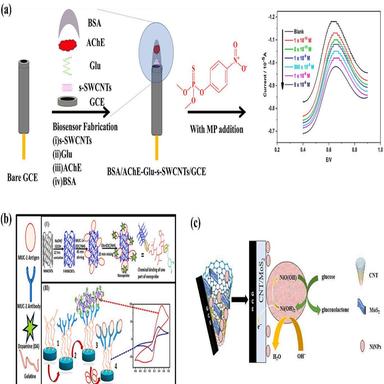
(a) schematic showing the procedures for making BSA/AChE-Glu-s-SWCNTs/GCE biosensors for MP detection by SWV; Reproduced with permission, (b) a schematic showing the (I) different procedures for making a nanoprobe; and (II) the surface modification of the working electrode and basic principles of a direct competitive biosensor for the detection of breast cancer.(1) Electrooxidative grafting of gelatin on a pencil electrode, (2) EDC/NHS-attested binding of MUC-1 antibody, (3) attachment of dev